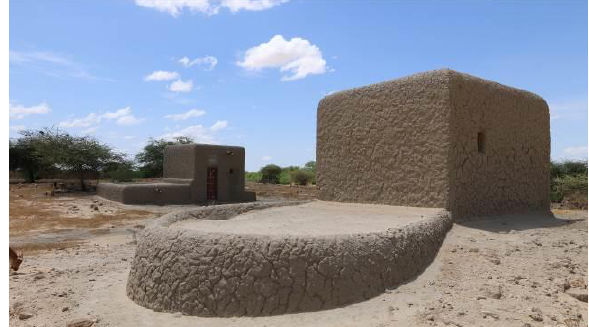
Figure 7. Mausoleum of Cheik Alpha Moya after its reconstruction - September 2015. © Joffroy T.